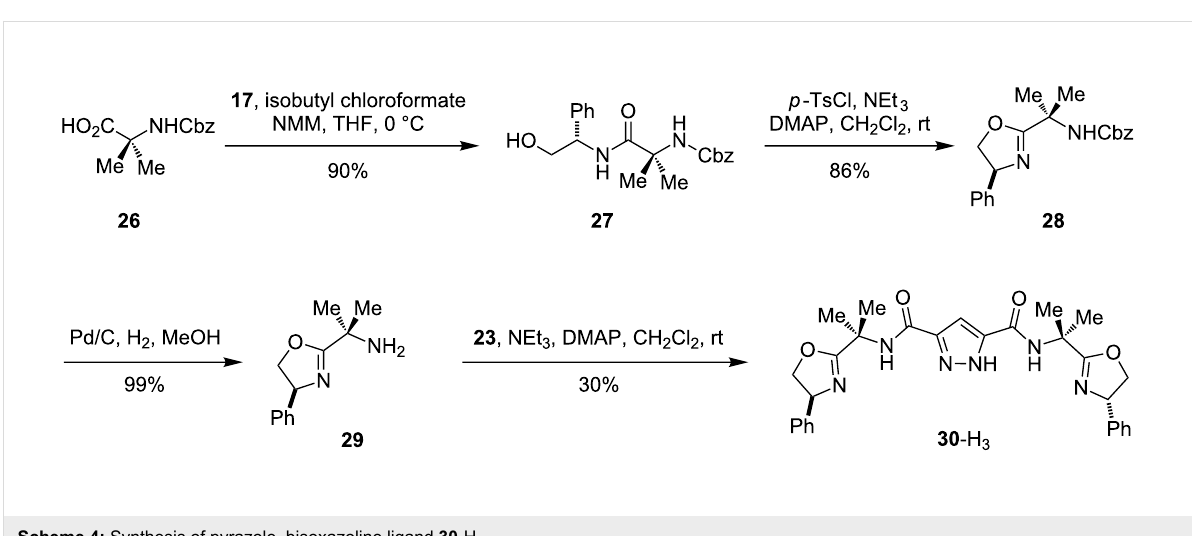
Scheme 4: Synthesis of pyrazole–bisoxazoline ligand 30 -H 3 .